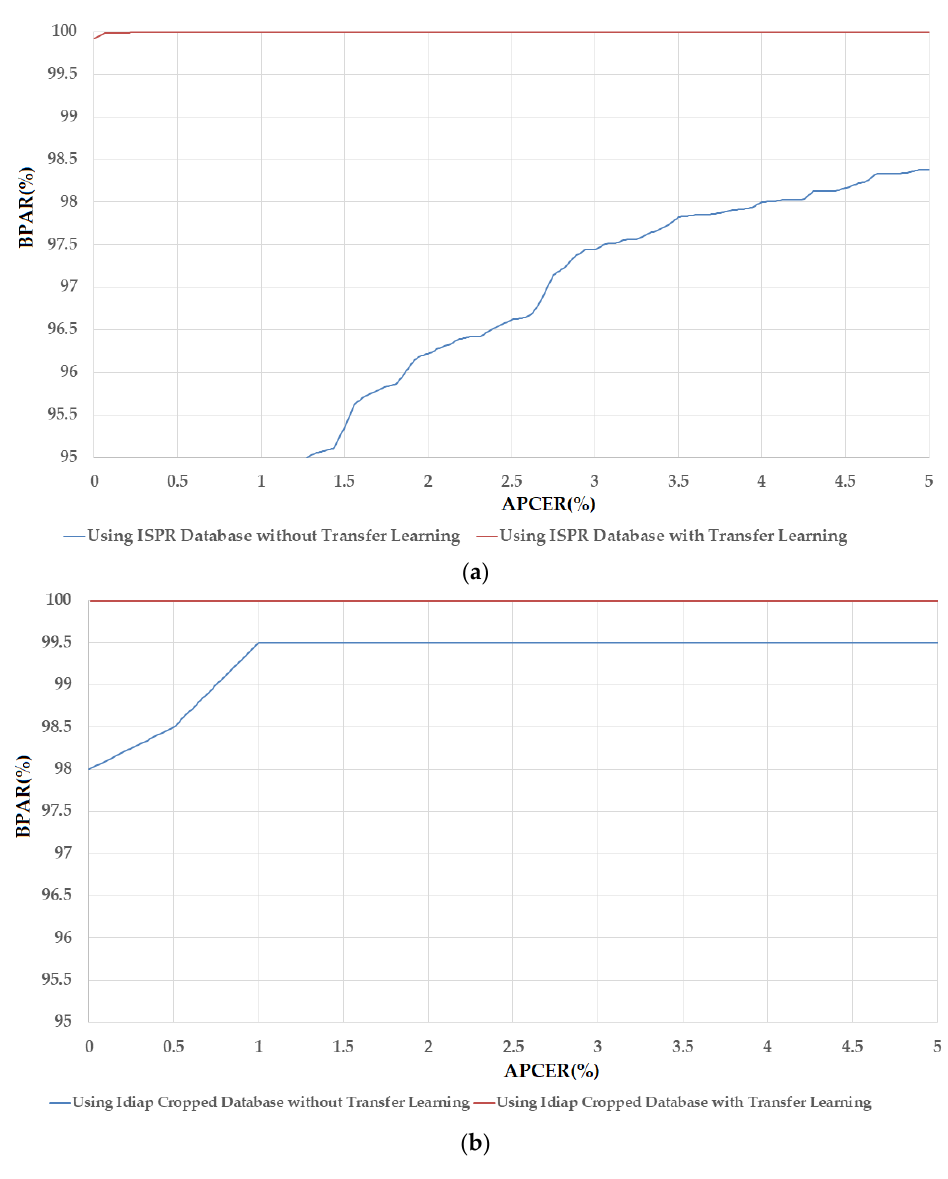
Figure 10. The DET curves of various system configurations using our proposed method based on VGG-16 network on two different databases: ( a ) ISPR-DB database; and ( b ) Idiap Cropped-DB database.